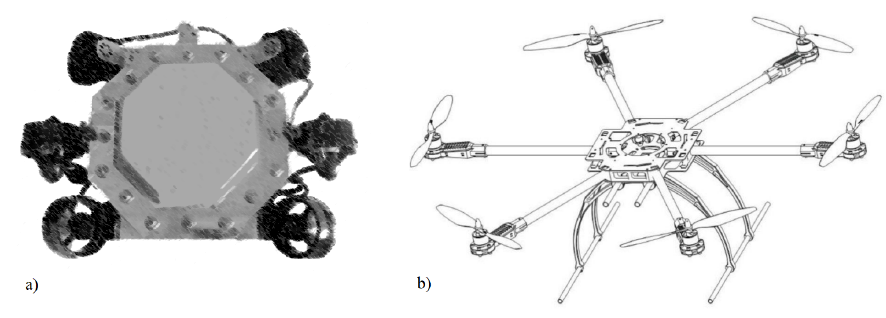
Figure 1. Systems described with k -out-of- n models (( a ) unmanned underwater vehicle, ( b )